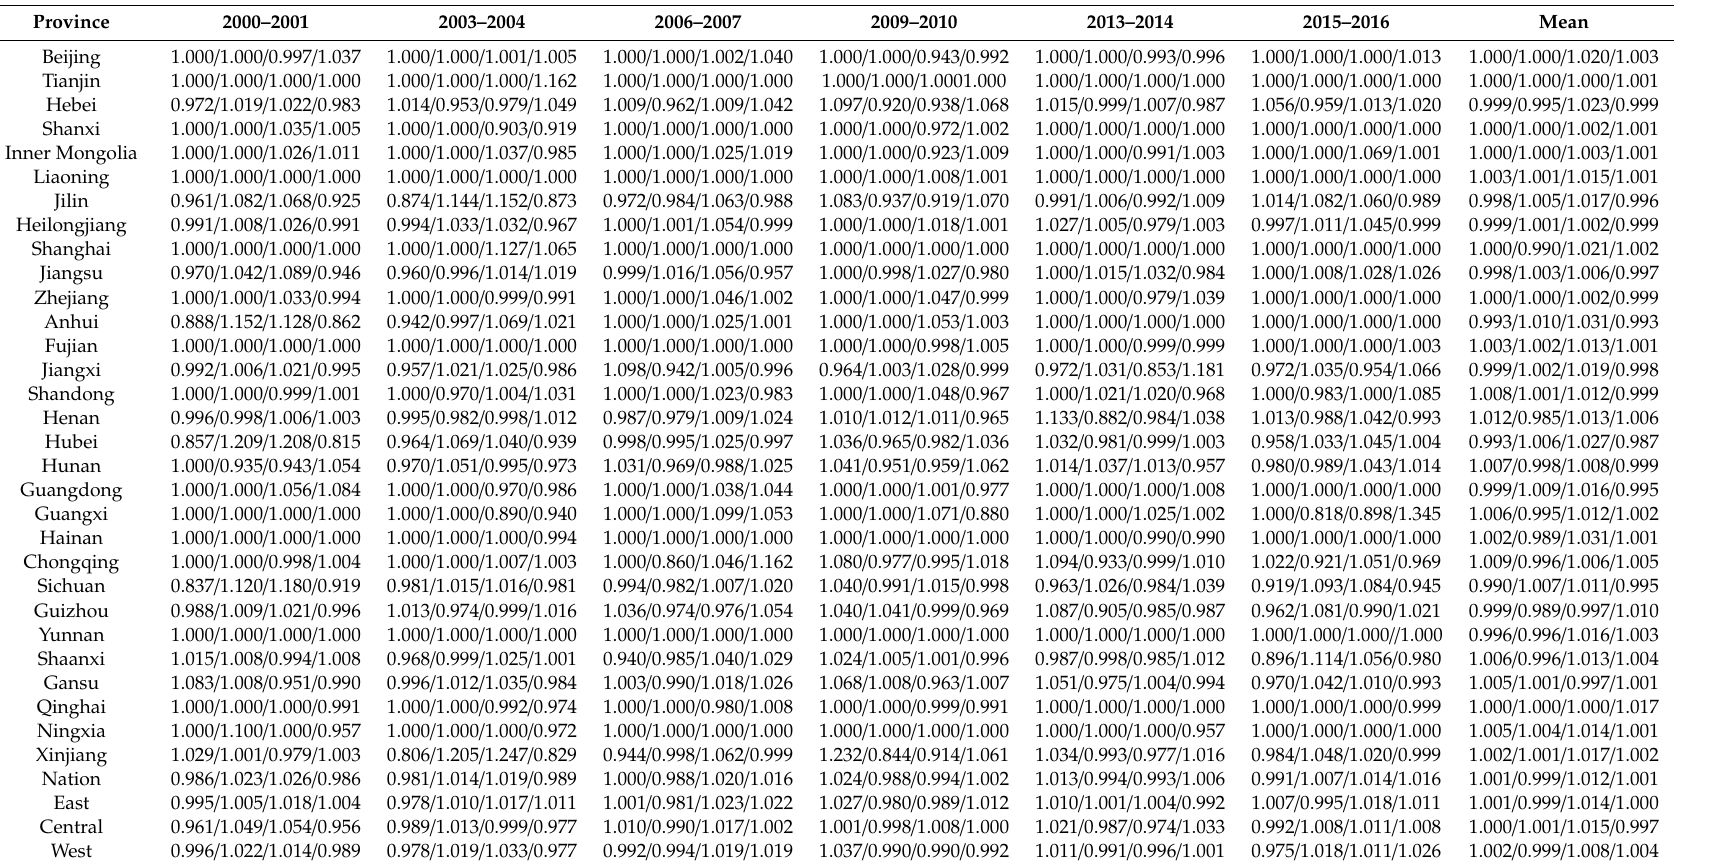
Table 4. Decomposition of the HDDF-GML Index of water resources green e ffi ciency in China for selected years during the study period 2000–2016.